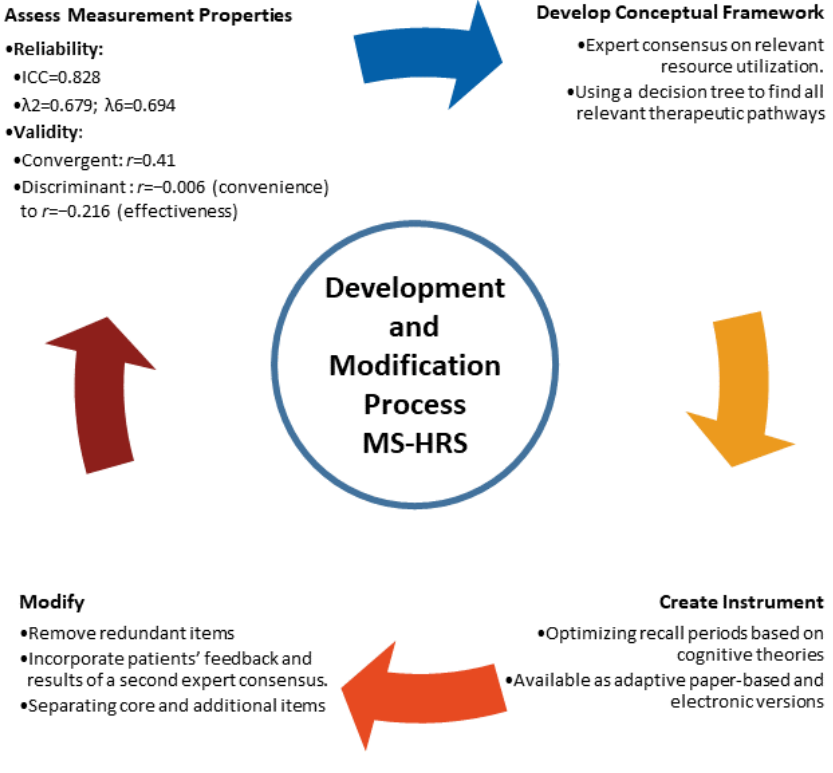
Figure 2. Development and modification process of the Multiple Sclerosis Health-Resource Utilization Survey. ICC: intraclass correlation coefficient; λ 2: Guttman lambda 2; λ 6: Guttman lambda